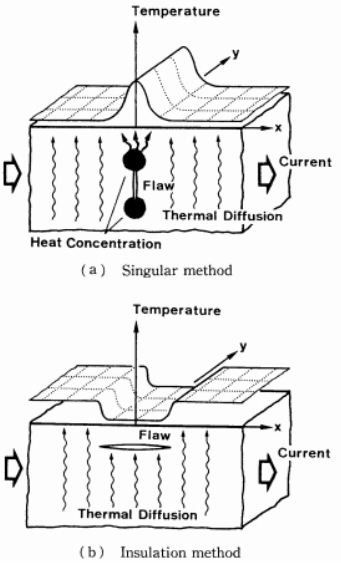
Figure 20. Illustration of the “singular method” ( a ) and the “insulation method” ( b ), from 31. with permission